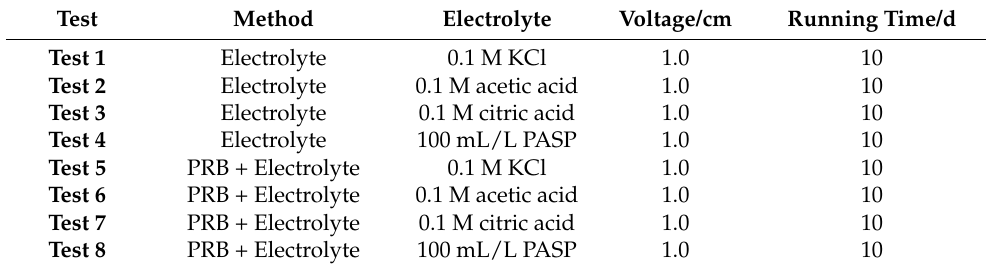
Table 2. Experimental conditions for electrokinetic remediation of Cu-contaminated